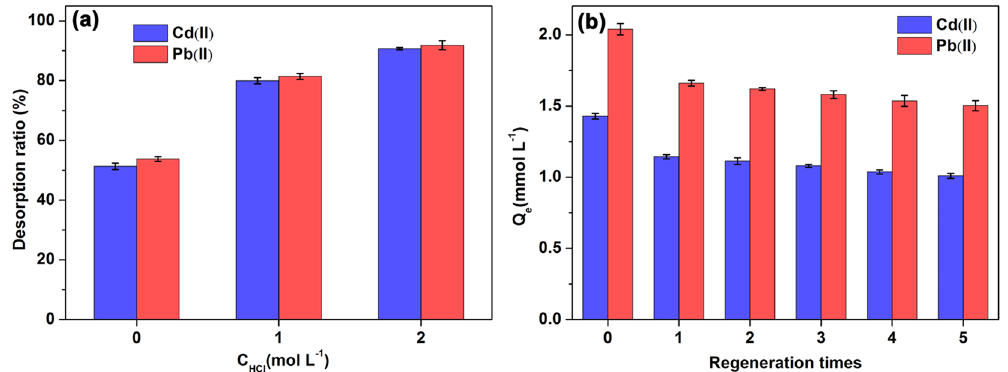
Figure 6. ( a ) The desorption of metal ions by different concentrations of HCl; ( b ) Reusability of SR-PAA during five cycles (The desorption solution was 1 mol L − 1